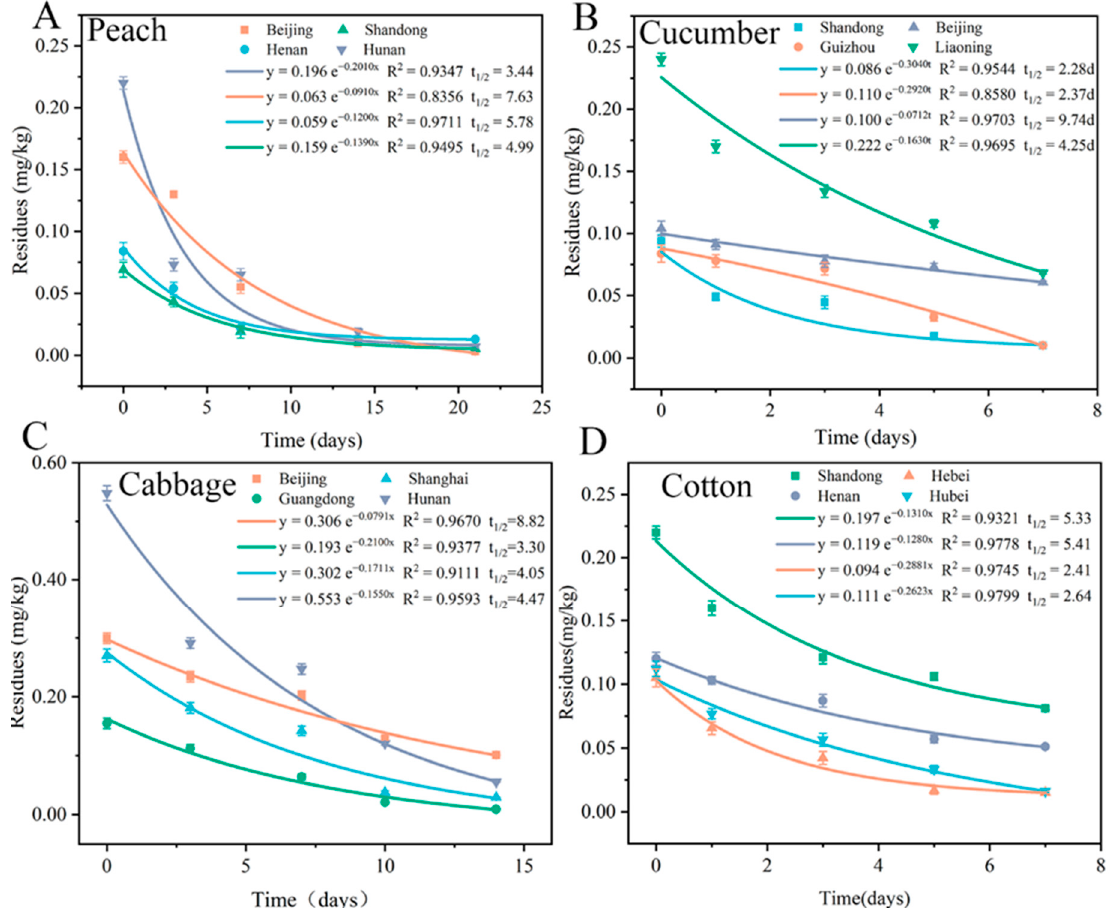
Figure 3. The dissipation dynamics, dissipation kinetics and half-life of flonicamid in ( A ) peach, ( B ) cu-cumber, ( C ) cabbage, ( D ) cotton.four crops.